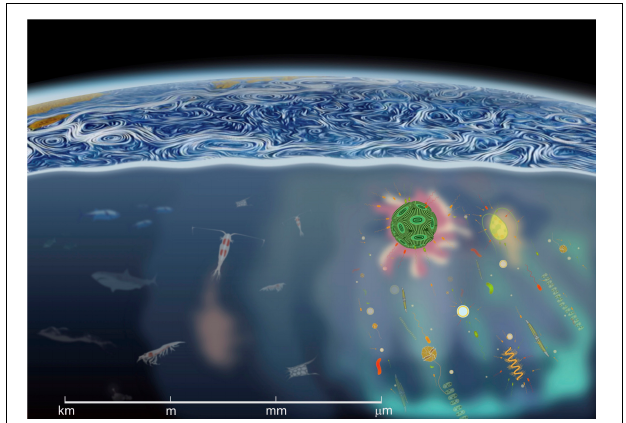
FIGURE 1 | A cross-scale view of the ocean spanning from linear gradients and microscale interactions (right), to top predators and mammals and regional circulation patterns (left and top). The scale at the bottom provides a reference of the spatial dimension in which the interactions between distinct organisms occur. The linear microbial landscape is embedded in a world of turbulent motions and progressively larger